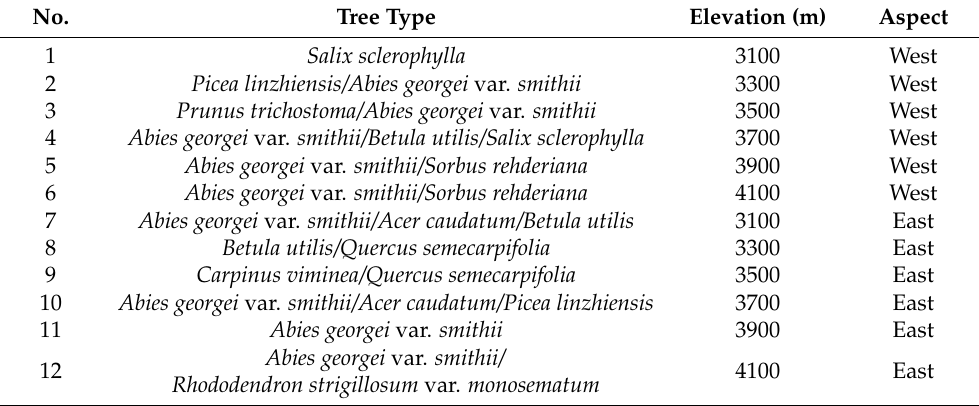
Table 1. Information on the tree species, elevation, and aspect of the sample